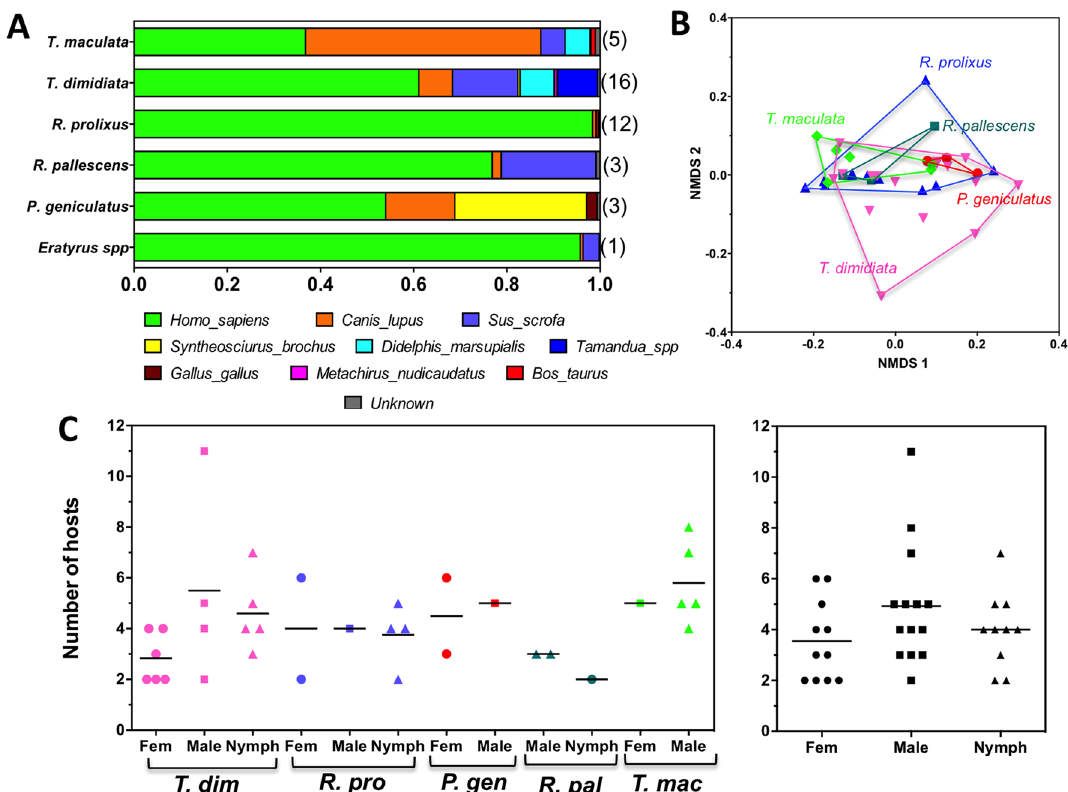
Figure 2. Triatomine feeding profiles. ( A ) Feeding profile of the indicated triatomine species. Vertebrate feeding hosts are color coded as indicated. Numbers in parenthesis on the right indicate sample size. Note the different feeding proportion on humans. ( B ) NMDS analysis of feeding profiles among triatomine species. PERMANOVA, P = 0.027 ( R. pallescens, P. geniculatus and E. cuspidatus were excluded from the statistical analysis due to the limited sample size for these species). ( C ) Number of concomitant feeding hosts species detected in single bugs according to triatomine species (left panel) and according to sex/developmental stage (right panel). T. dim: T. dimidiata; R. pro: R. prolixus; P. gen: P. geniculatus; R. pal: R. pallescens; T. mac: T.